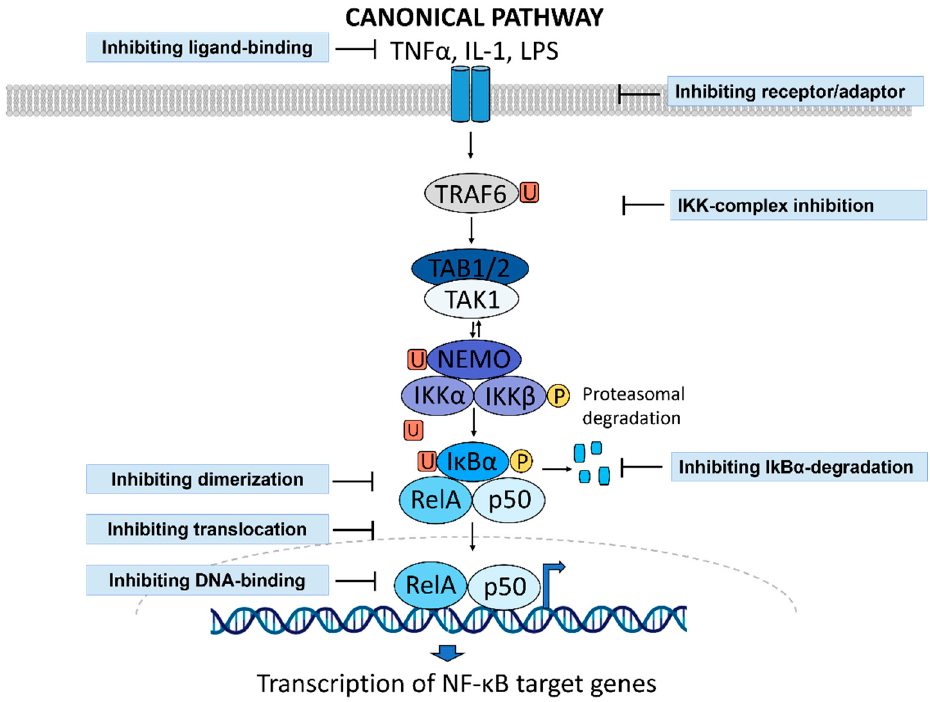
Figure 2. Strategies to inhibit NF- κ B signaling.